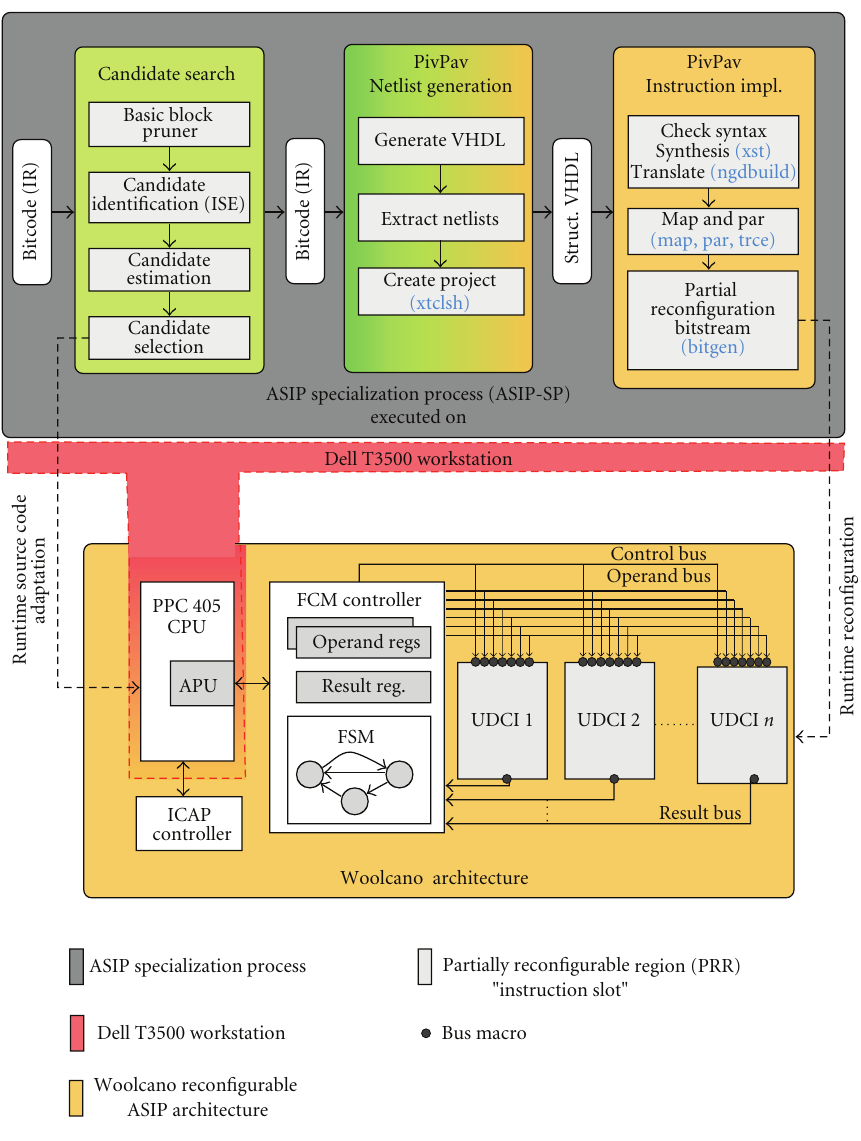
Figure 2: Overview of the developed tool flow and the targeted Woolcano hardware architecture. During experimental evaluation, instead of a PPC405 CPU, the ASIP specialization process was executed on a Dell T3500 workstation; see Section 10 for